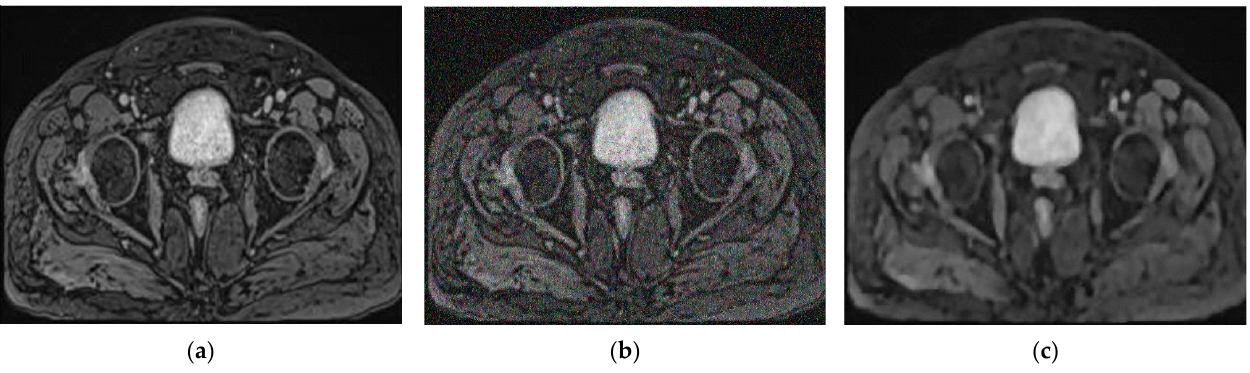
Figure 2. Examples of MRI images ( a ) original; ( b ) with Gaussian noise; ( c ) after applying residual learning.